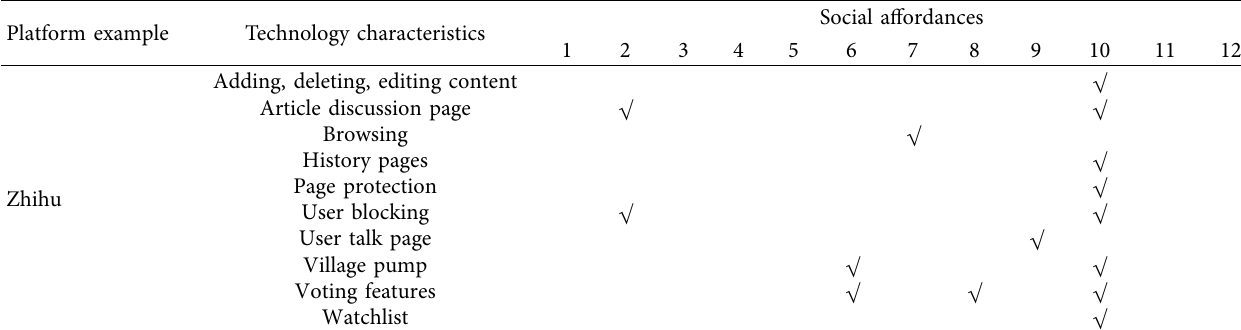
Table 4: Research on the relationship between social affordances and technology characteristics.